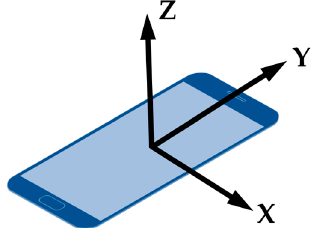
Figure 3. Three axes of magnetometer on smartphone.